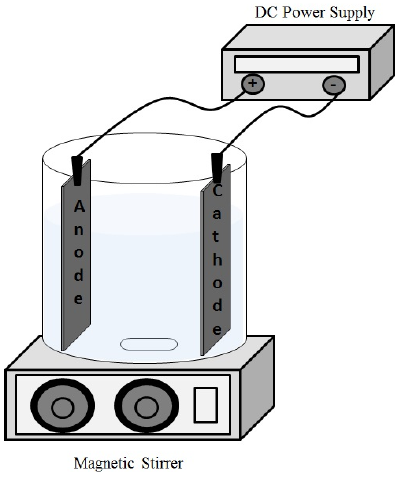
Figure 1. Experimental setup of the electro-chemical reactor.